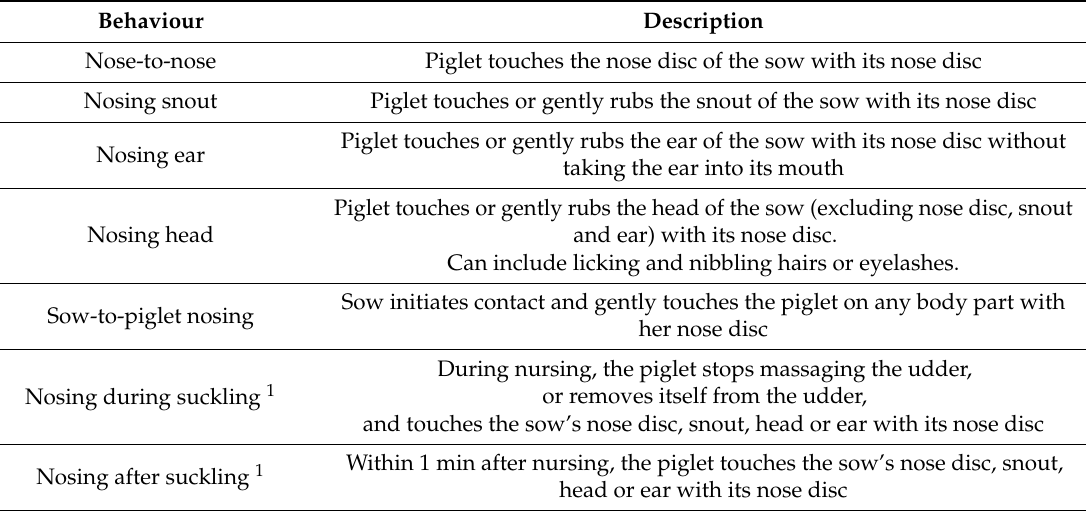
Figure 1. Target areas of the four types of piglet-to-sow nosing behaviours: nose-to-nose (top left), nosing snout, with snout area indicated between dotted lines (top right), nosing ear (bottom left), and nosing head (bottom right). Table 2.